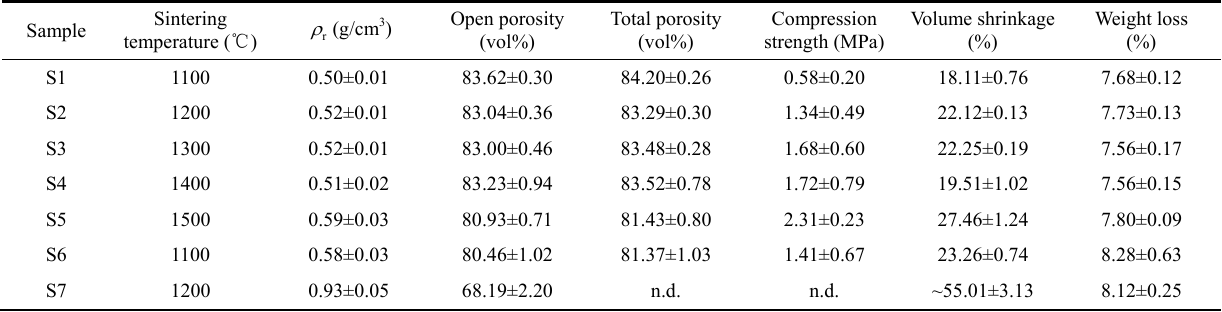
ρ , open porosity, total porosity, compression strength, volume shrinkage, and weigh loss data of different r samples after sintering